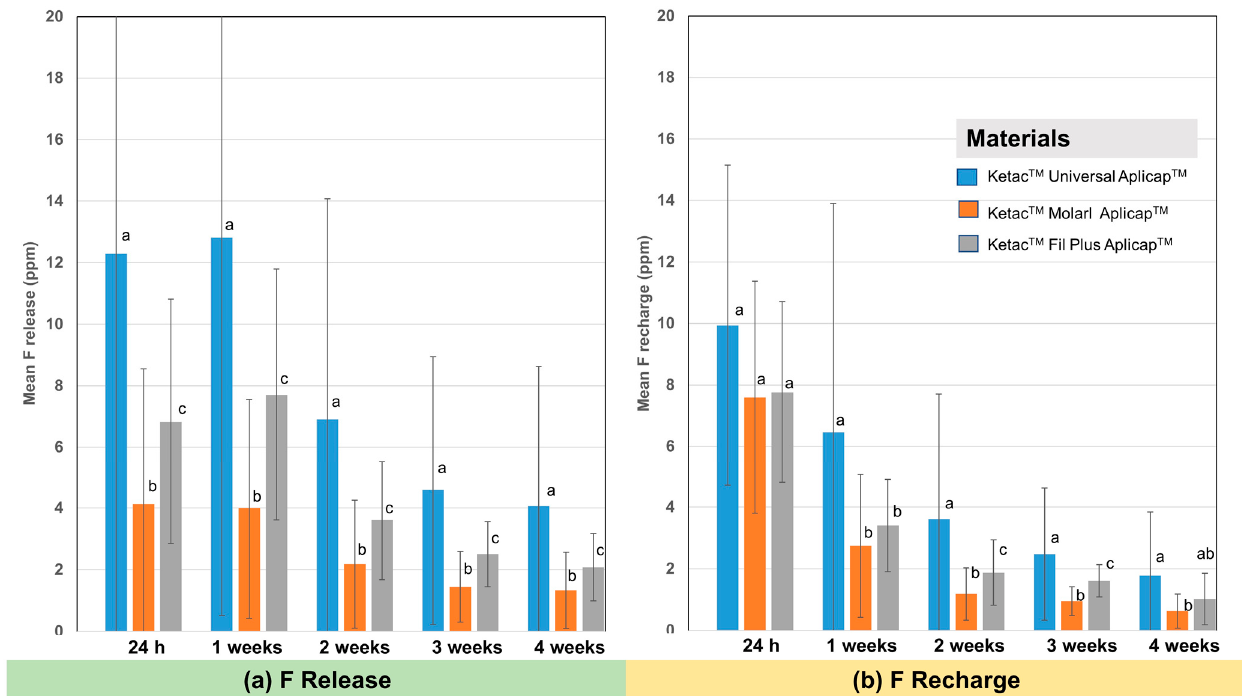
Figure 2. Means of the amount of fluoride (ppm) in each material (Ketac TM Universal Applicap TM ,